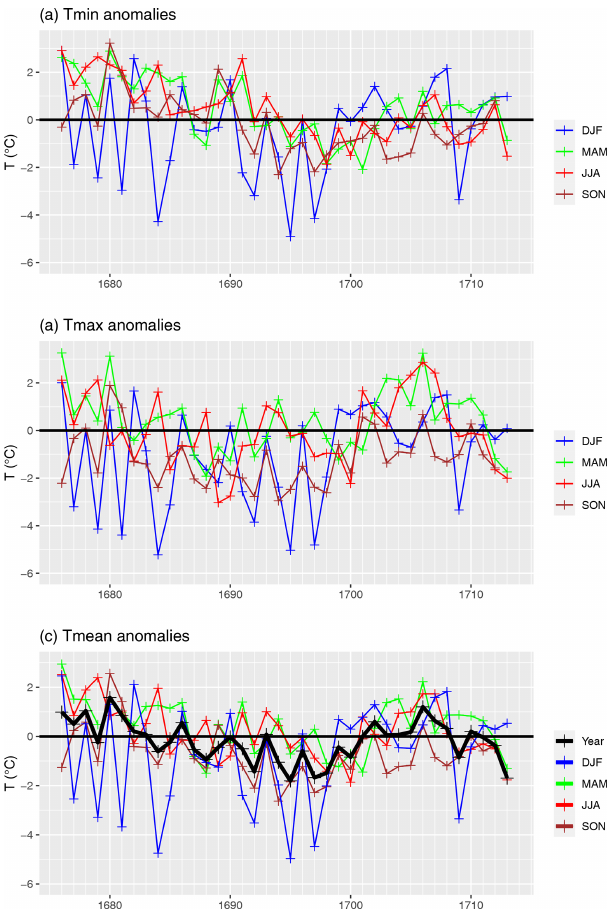
Figure 5. Seasonal temperature anomalies (DJF: December, Jan- uary, February; MAM: March, April, May; JJA: June, July, August; SON: September, October, November) for (a) minimum, (b) max- imum, and (c) mean temperature from 1676–1713 with respect to the mean value from 1961–1990 (E-OBS). In addition, in (c) the annual mean temperature is shown.